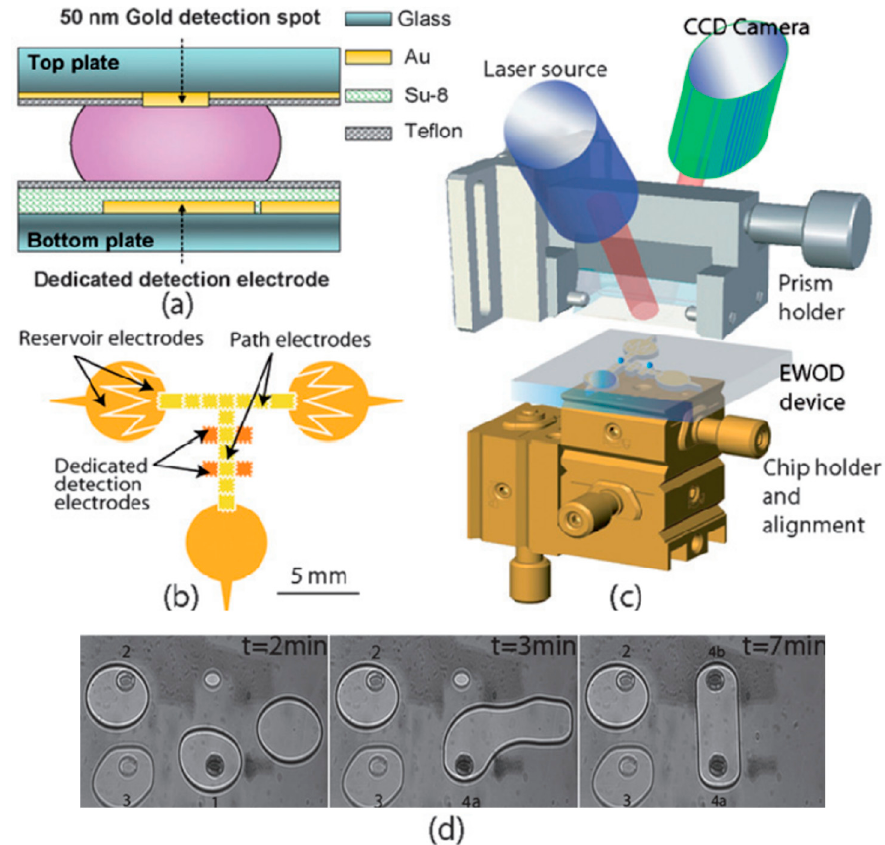
Figure 7. A schematic illustration of a EWOD-SPR sensor chip; ( a ) from side view, ( b ) from bottom view, ( c ) mounted on the SPR measurement system, ( d ) SPR imaging of four EWOD-SPR sensing spots. Reprinted with permission from [70]. Copyright 2009 The Royal Society of Chemistry.